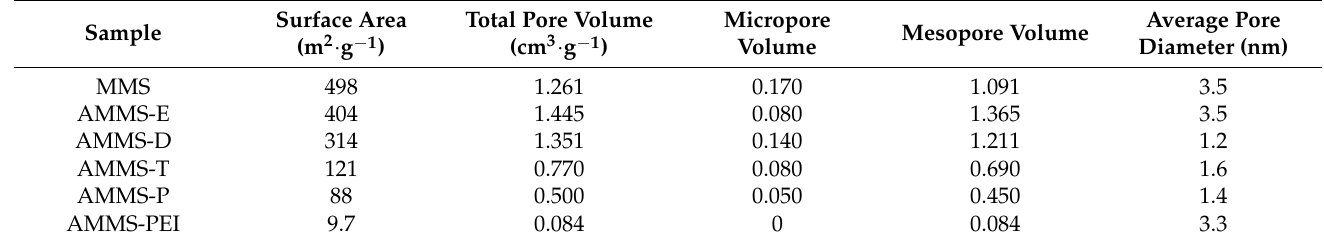
Table 2. Nitrogen adsorption/desorption characterization details for MMS and AMMS.